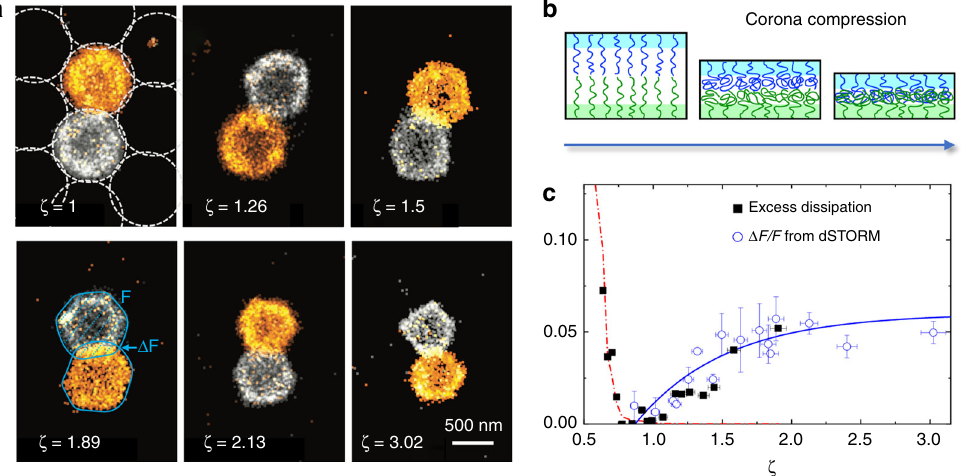
Fig. 6 Densely packed suspensions of neutral microgels: deformation, interpenetration, and compression. a Two-color 2D dSTORM of dye-labeled microgels embedded in a matrix of unlabeled microgel particles, indicated by dashed circles in the left upper panel. ζ is the effective volume fraction. SRFM imaging of speci fi cally labeled microgel pairs reveals partial interpenetration, faceting, and fi nally isotropic compression, leading to a decreasing global size. Contour lines are shown for ζ = 1.89 to illustrate the overlap area Δ F relative to the total area F of a particle for the image section shown. Image adapted from ref. 110 . b Interpenetration mechanism at the particle – particle interface suggested in ref. 25 based on the dSTORM data. c Evidence that the dissipative (cid:3) (cid:4) behavior, expressed by the excess dissipation tan δ exc ¼ G 00 = G 0 (cid:2) G 00 = G 0 at ω ≃ 1 rad/s, scales with the overlap area 0.4 × Δ F / F . The solid blue line is a min guide to the eye, and the red dash-dotted line denotes 1 = G 0 . These results suggest that information from nanoscale SRFM imaging can be directly used to model viscoelastic properties. Panels ( b ) and ( c ) were adapted from ref. 25